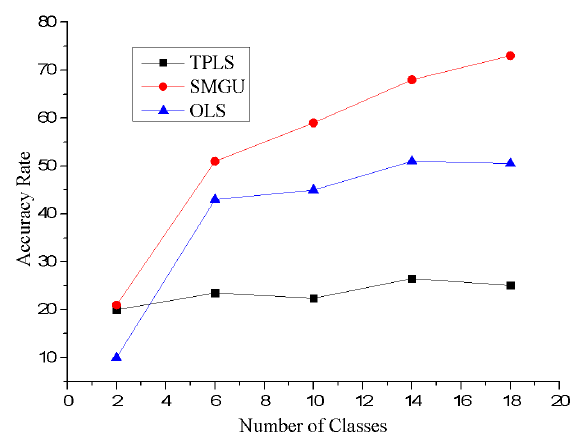
Fig. 4. Prediction accuracy rate of different labeling